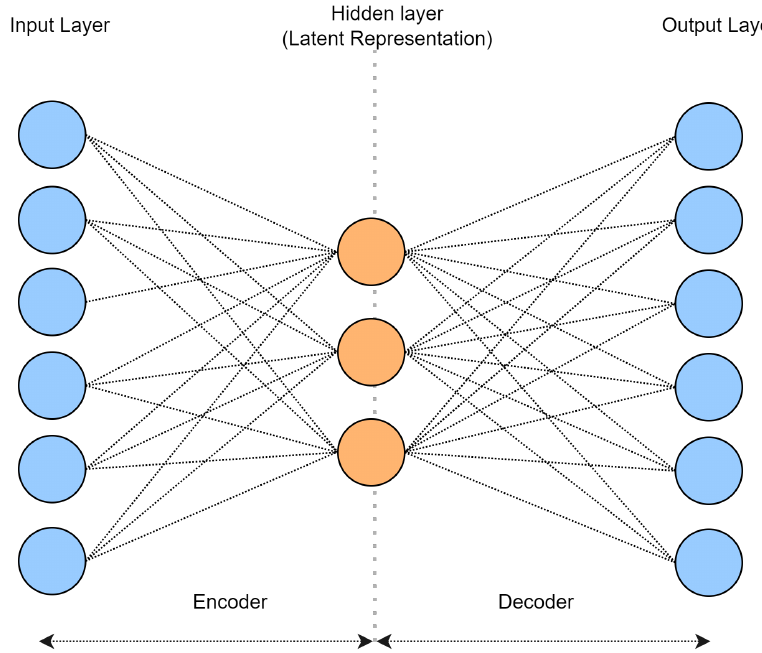
Figure 3. Undercomplete